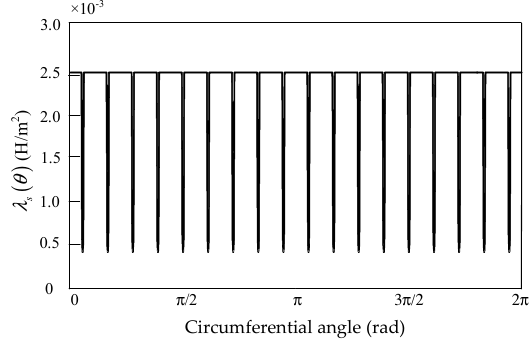
Figure 4. Air-gap permeance waveform of stator slotting.